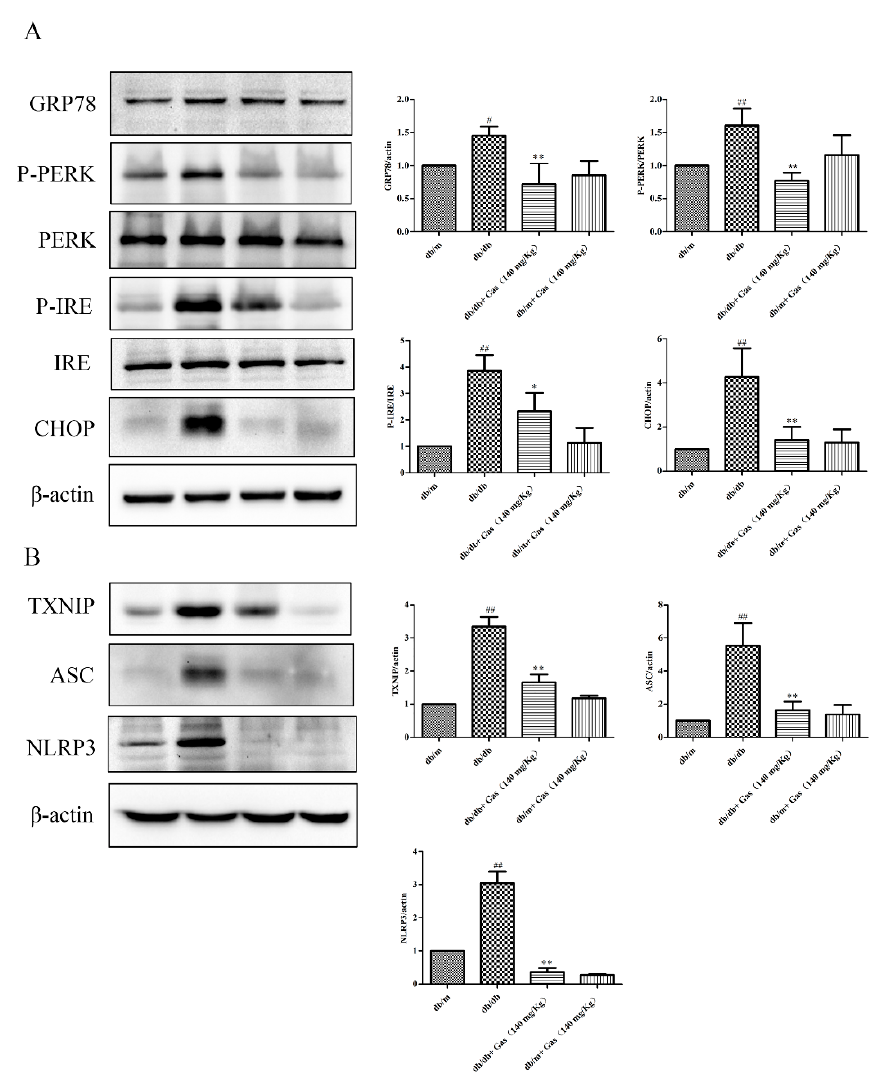
Figure 8. Gas inhibits ER stress in the hippocampus of db/db mice. ( A ) Representative protein bands and Western blot analysis of GRP78, P-PERK, PERK, IRE, P-IRE, CHOP in the hippocampus of each group. ( B ) Representative protein bands and Western blot analysis of TXNIP, NLRP3, ASC in the hippocampus of each group. Values are represented as means ± SD for three mice in each group. # p < 0.05, ## p < 0.01, compared with the db/m group. * p < 0.05, ** p < 0.01, compared with the db/db group.